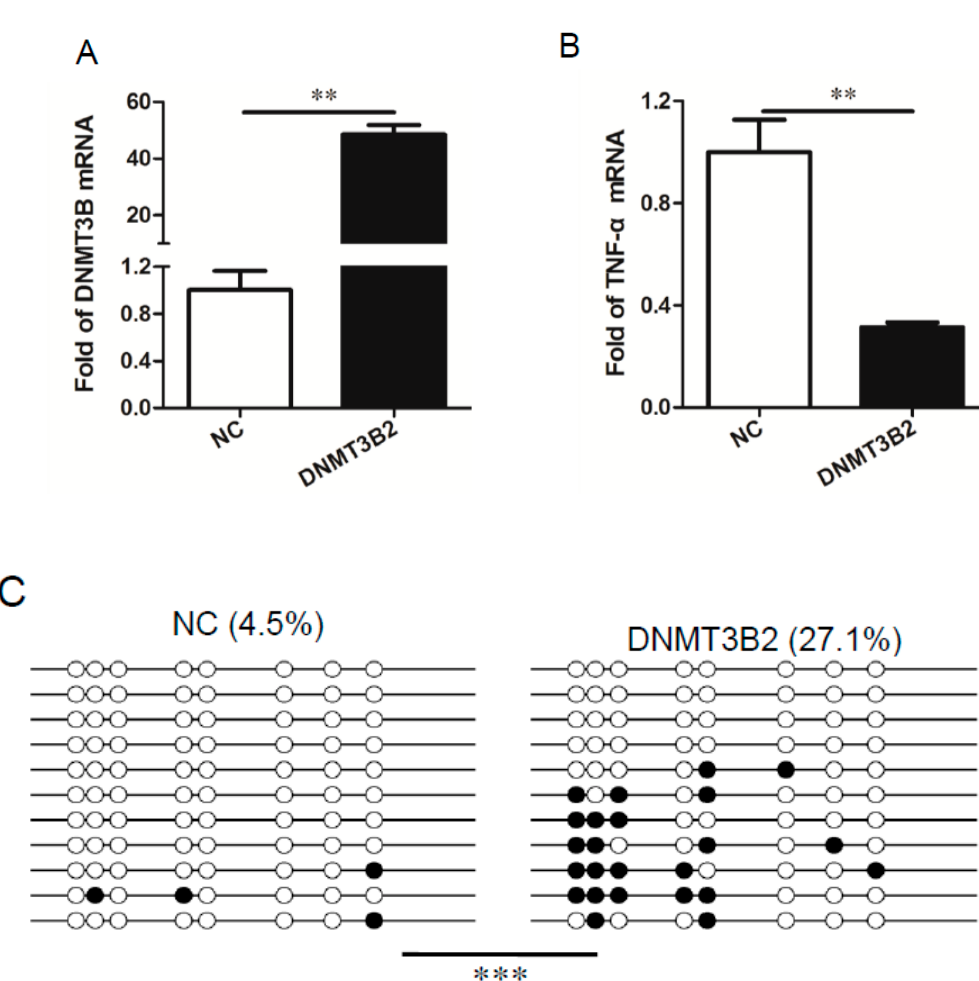
Figure 6. Effect of overexpression of DNMT3B2 by lentivirus on TNF- α transcription and methylation profile of TNF- α promoter. PAM were infected with lentivirus overexpressing DNMT3B2 or containing control vector. After 48 h of infection, cells were stimulated with LPS (1 µ g / mL) for 6 h. Subsequently, cells were harvested, mRNA was extracted and analyzed for expression of DNMT3B2 ( A ) and TNF- α ( B ) by qRT-PCR, respectively. Data are shown as mean (SD) ( n = 3). *, p < 0.05; **, p < 0.01. In the meanwhile, cells were treated as shown above, and the total DNA was collected and analyzed for the DNA methylation level of the TNF- α promoter region by BSP ( C ). Each line represents one individual sequenced clone. One circle represents one CpG site: the open circle shows unmethylated CpG; the black circle shows methylated CpG. Note that overexpression of DNMT3B2 significantly increased the DNA methylation level of the TNF- α promoter region in comparison to control group. The difference between DNMT3B2 group ( n = 3) and control group ( n = 3) was calculated by Fisher’s exact test, ***, p < 0.001.